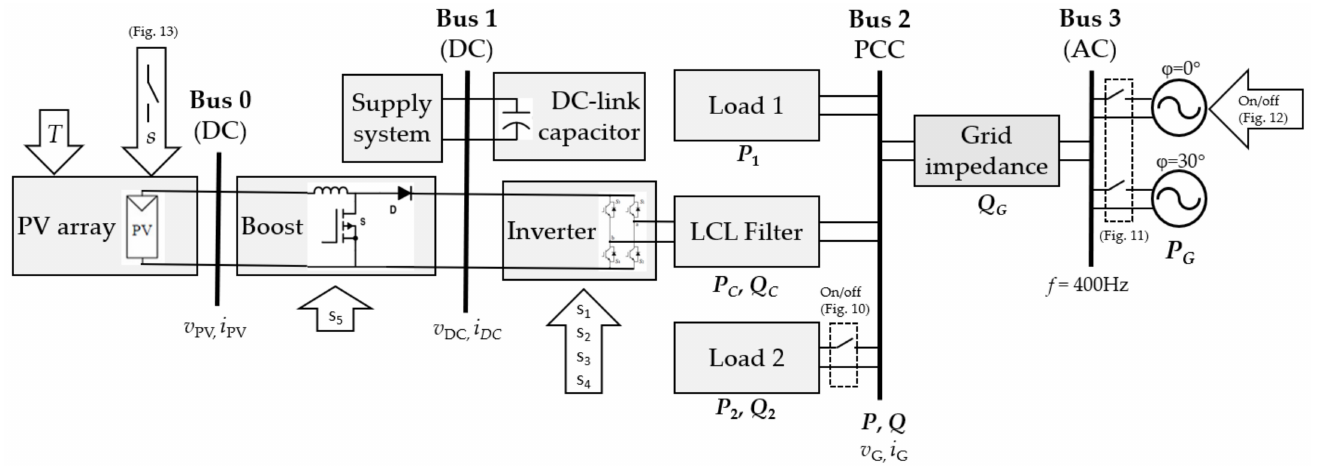
Figure 2. Configuration scheme of the investigated system, excluding the control